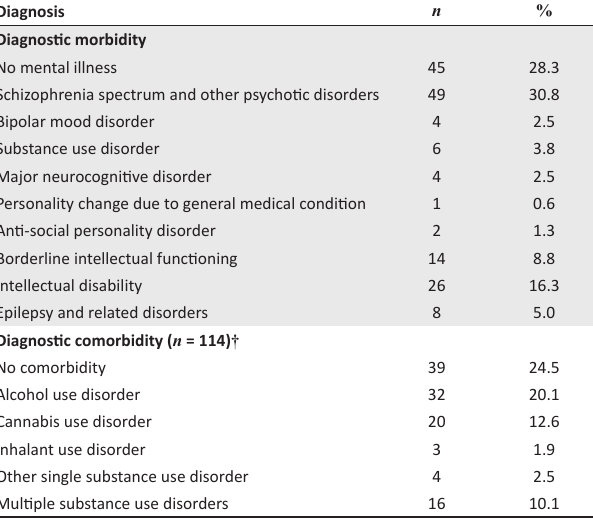
TABLE 2: Clinical diagnoses amongst alleged rape offenders ( n = 159).